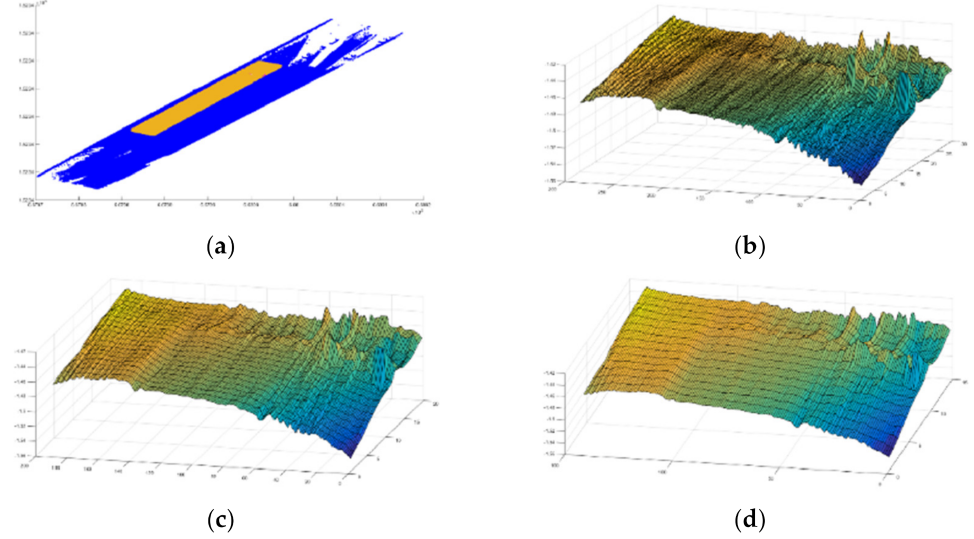
Figure 14. ( a ) Cropped area, ( b ) 10 cm × 10 cm mesh size, ( c ) 15 cm × 15 cm mesh size, and ( d ) 20 cm × 20 cm mesh